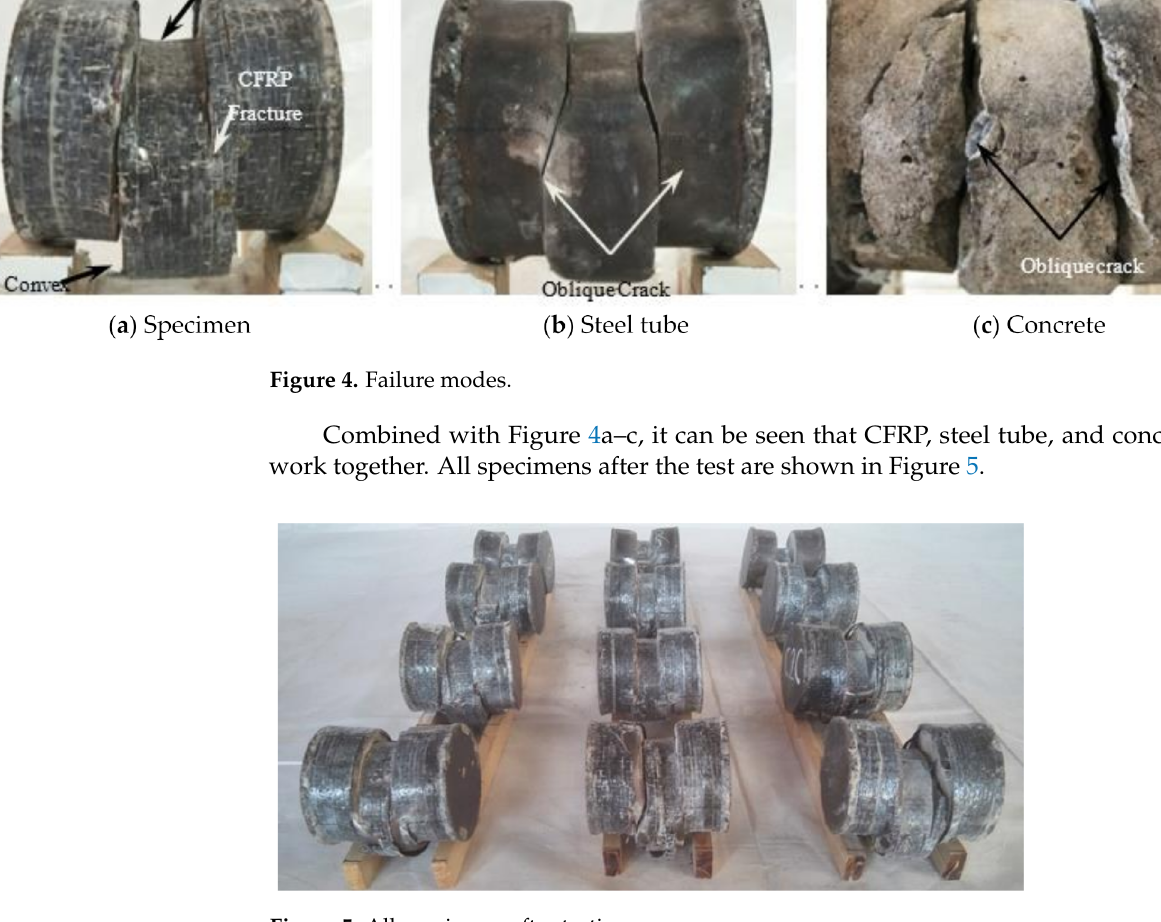
Figure 5. All specimens after